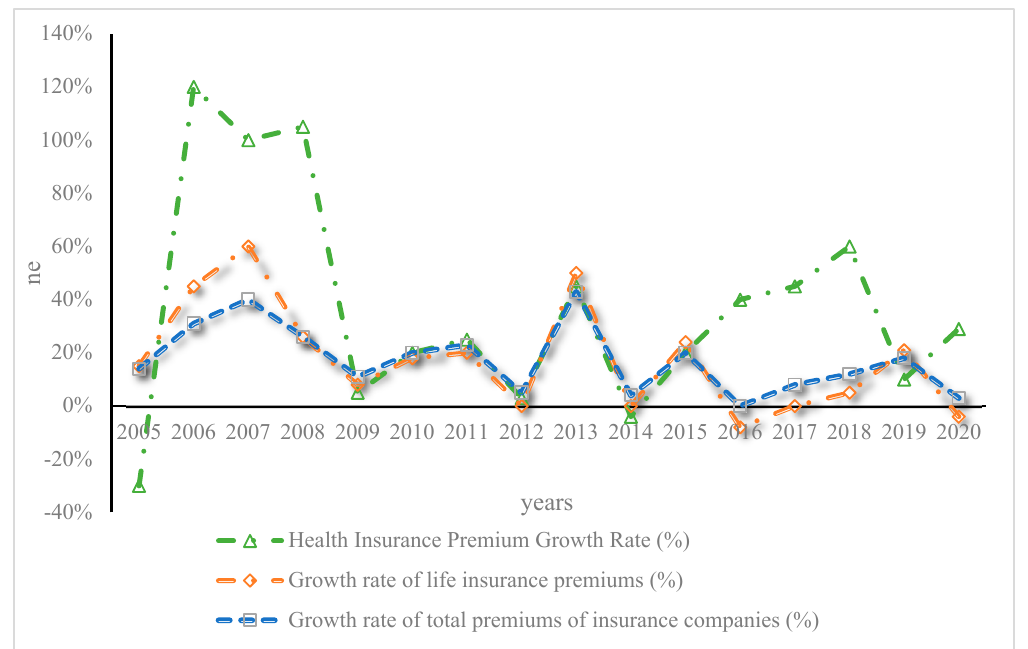
Figure 4. Comparison of the growth rates of the three types of premium income from 2005 to 2018.